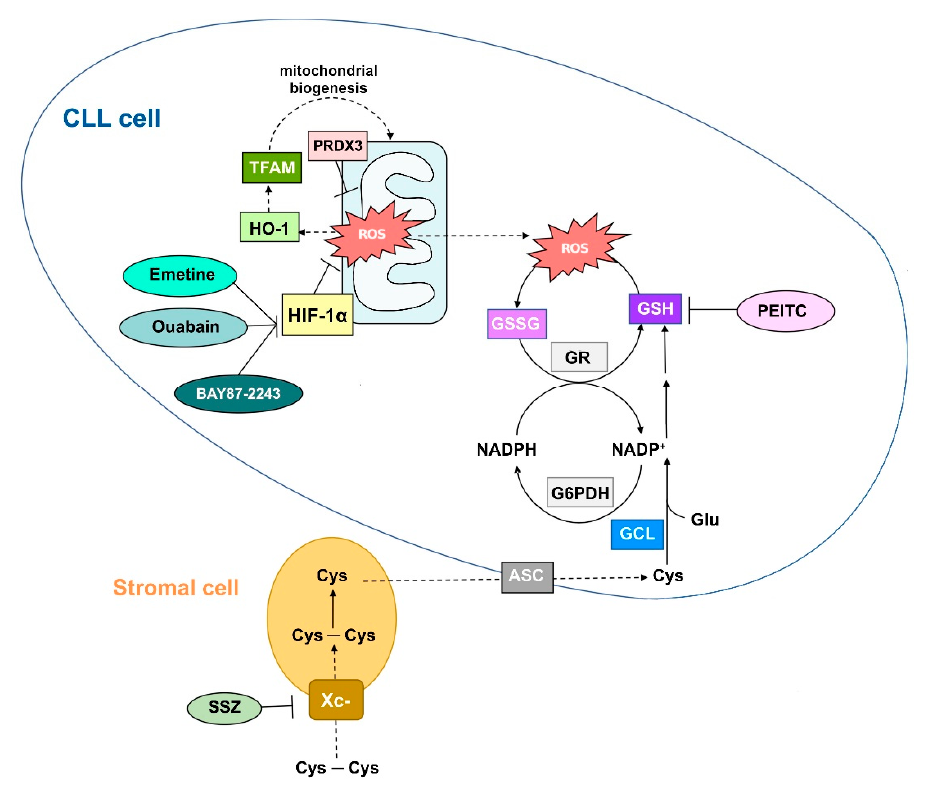
Figure 1. Schematic diagram showing key antioxidant systems in chronic lymphocytic leukemia (CLL) cells and small molecules capable of abolishing the redox balance, resulting in reduced CLL cell vitality. ASC, alanine-serine-cysteine transporter; Cys, cysteine; Cys-Cys, cystine-cysteine; G6PDH, glucose-6-phosphate dehydrogenase; GCL, γ -glutamyl cysteine ligase; GSH, glutathione; GSR, glutathione reductase; GSSG, glutathione disulfide; Glu, glutamate; HIF-1 α , hypoxia-inducible factor-1 α ; HO-1, heme oxigenase-1; NADP +/ NADPH, nicotinamide adenine dinucleotide phosphate; PEITC, β -phenylethyl isothiocyanate; PRDX3, peroxiredoxin 3; SSZ, sulfasalazine; Xc-, cystine